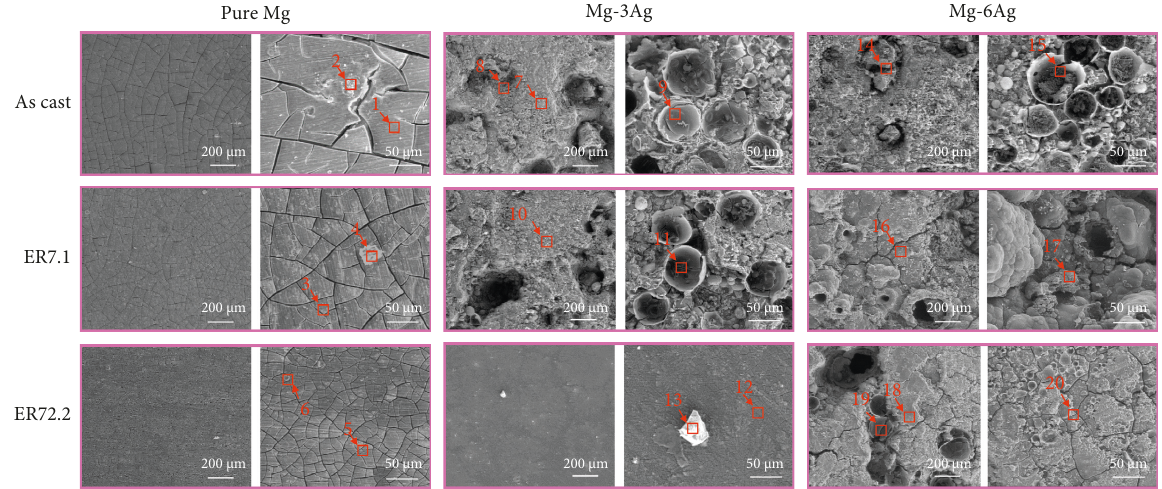
Figure 6: Microstructure observed by SEM of the sample surfaces after an immersion test for 16